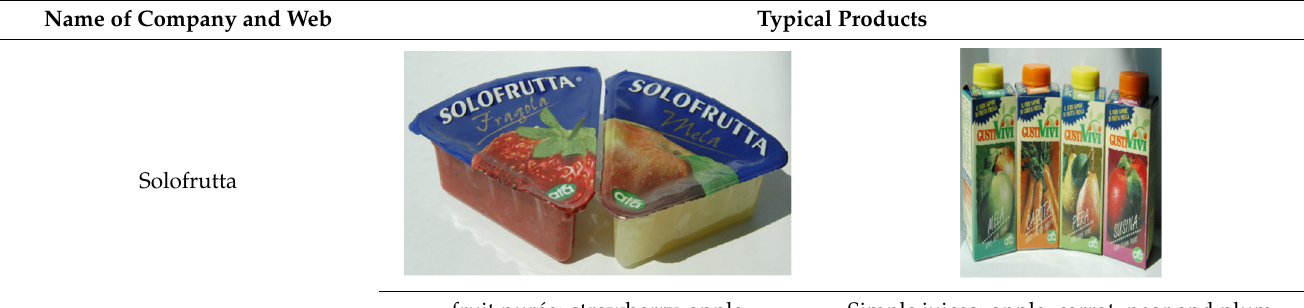
Table A11. High pressure treated products by the company Solofrutta.